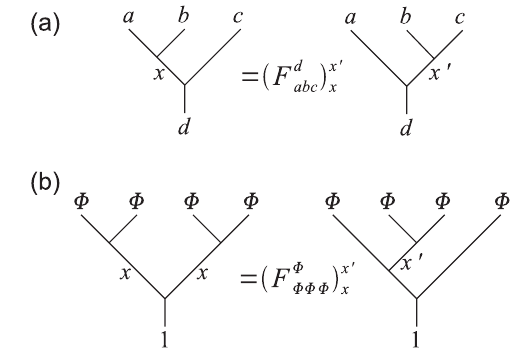
1. (a) The two fusion bases for three anyons ( a , b , and c ) created from an anyon d . The definition of the F matrix that relates these is shown. (b) The two fusion bases for four Φ anyons created from the vacuum. One is depicted to the left of the equation, whose intermediate step is labeled by x . The other, to the right, has an intermediate step x 0 . These are related by the same F matrix as three Φ anyons created from one Φ , as